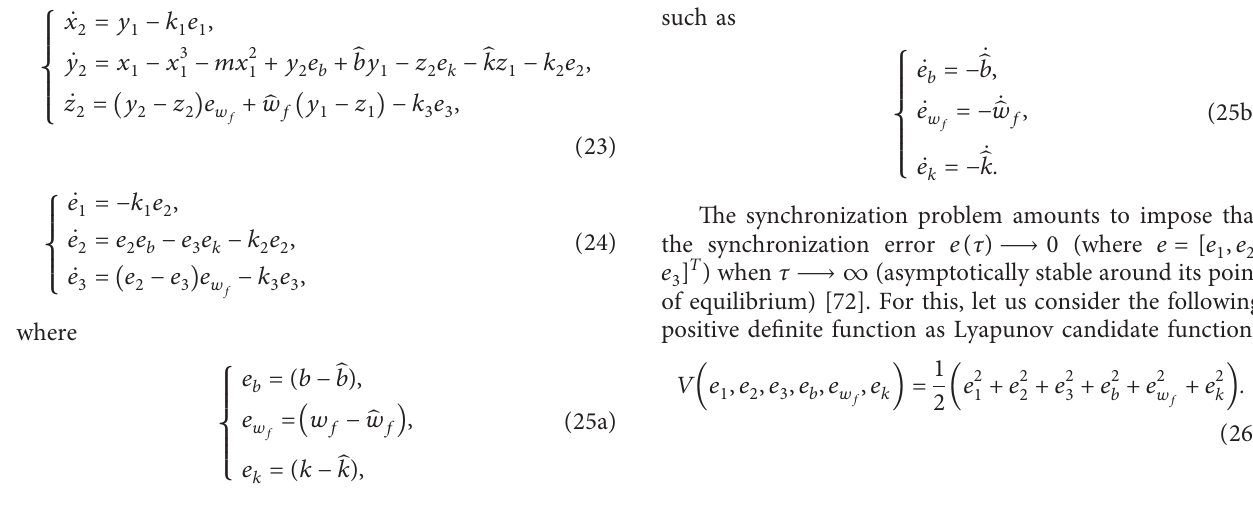
Figure 17: Representations of the four coexisting attractors obtained in PSpice with R conditions ( X (0), Y (0), Z (0)): (a) cycle of period-1 and (b) its symmetry for ( ± 0.13, 0, 0); (c) chaotic attractor and (d) its symmetry for ( ± 0.15, 0,